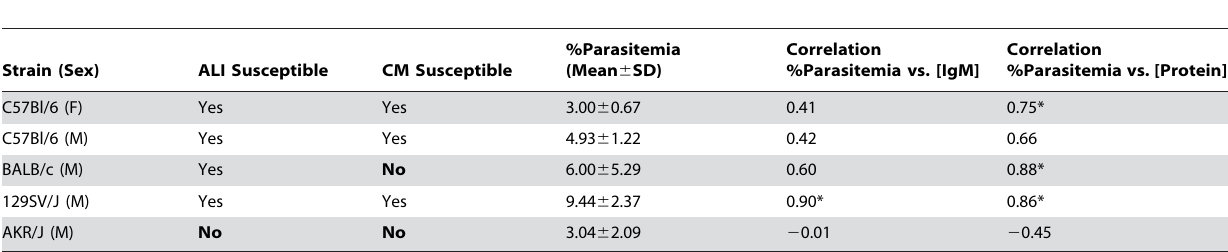
Table 2. Summary of the correlation between peripheral parasitemia and BAL IgM or total protein levels in all in-bred strains tested at Day 6 post-infection (*p ,